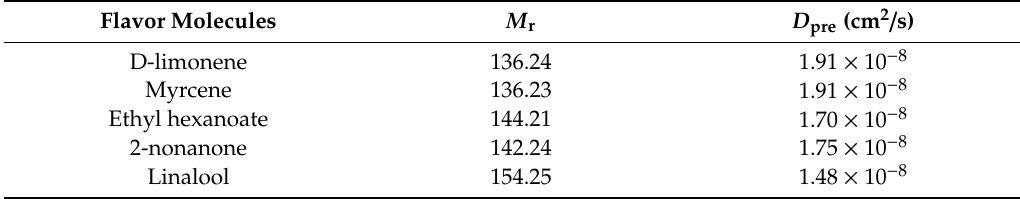
Table 3. Di ff usion coe ffi cients ( D pre ) calculated by Brandsch model.